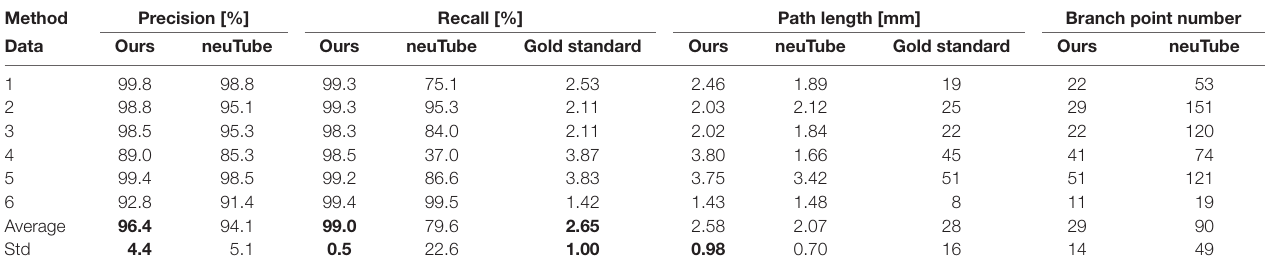
Bold values represent best achieved evaluations and gold